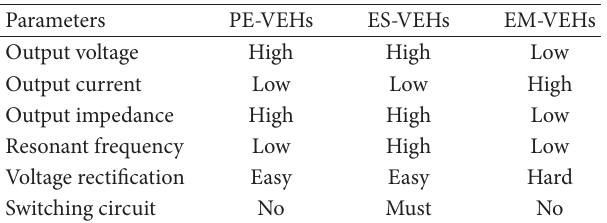
Table 6: Comparison of basic types of vibration-based energy